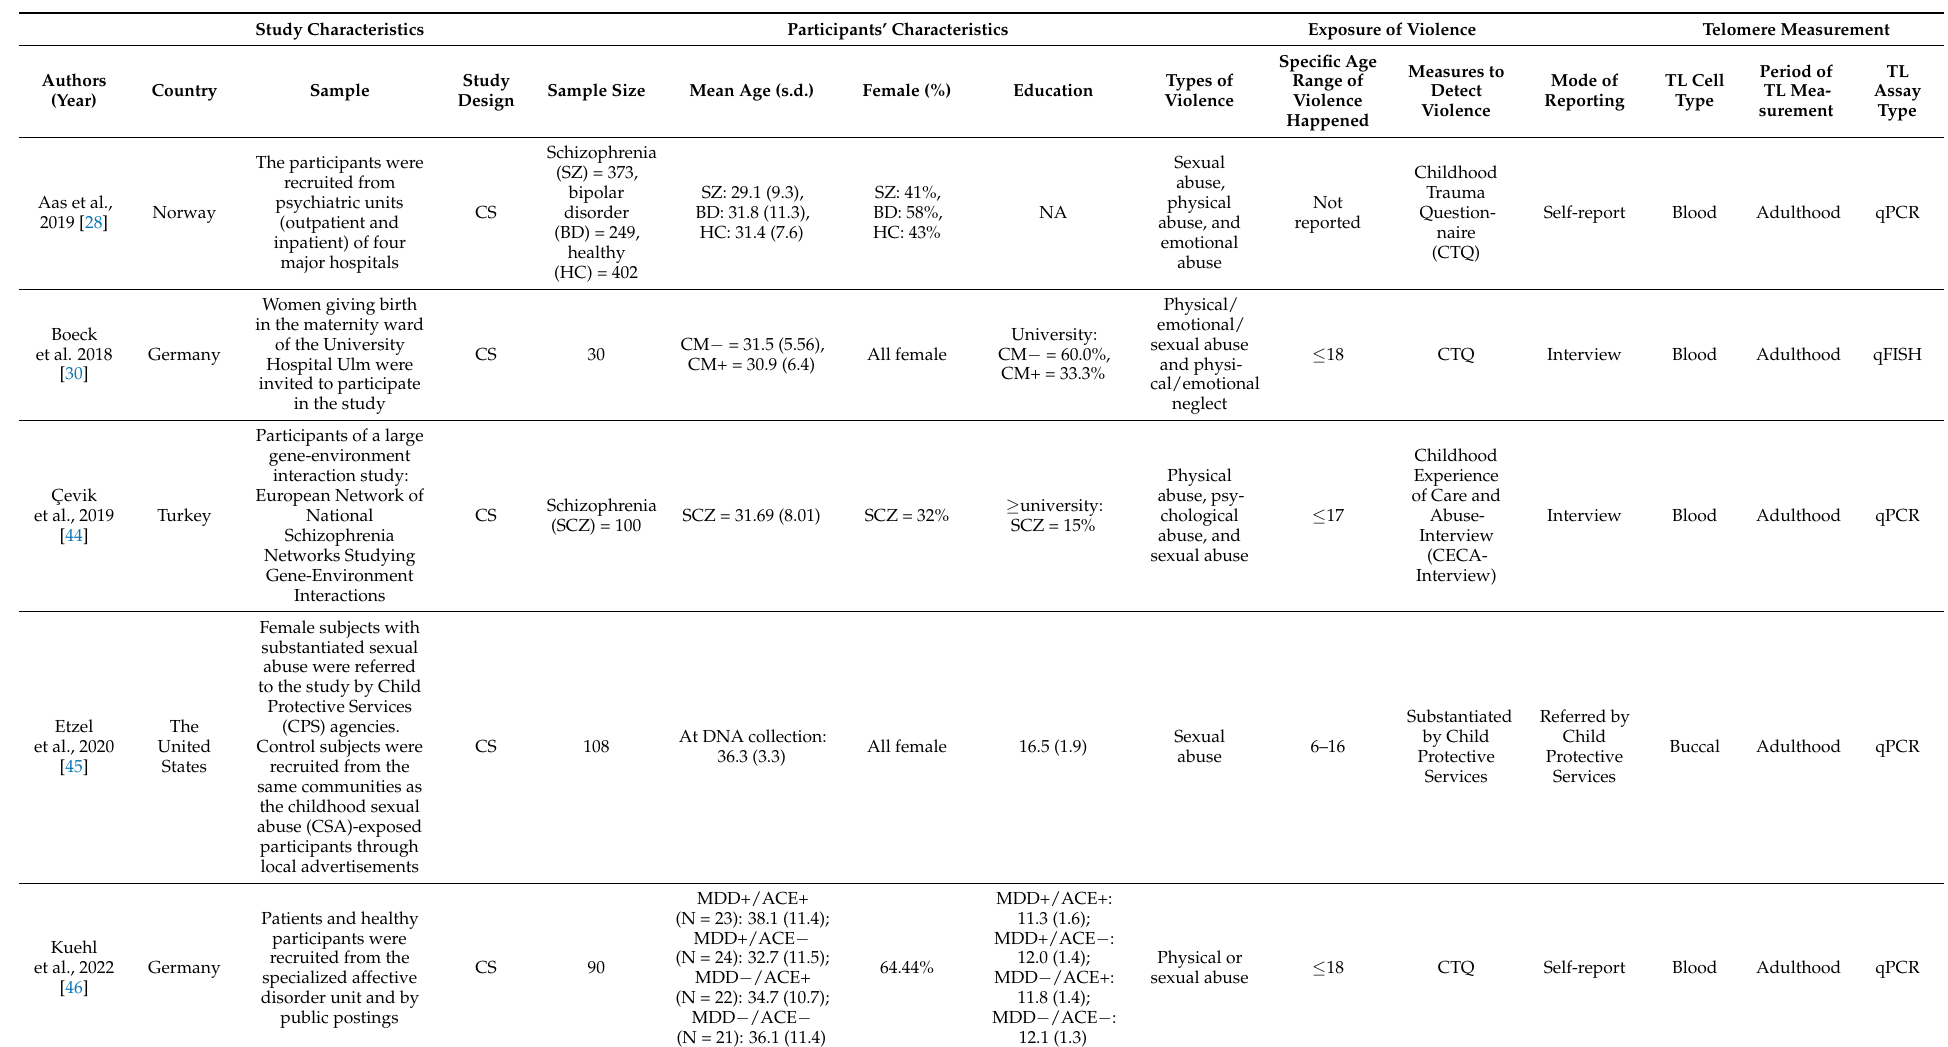
Table 1. Characteristics of measures used in the included